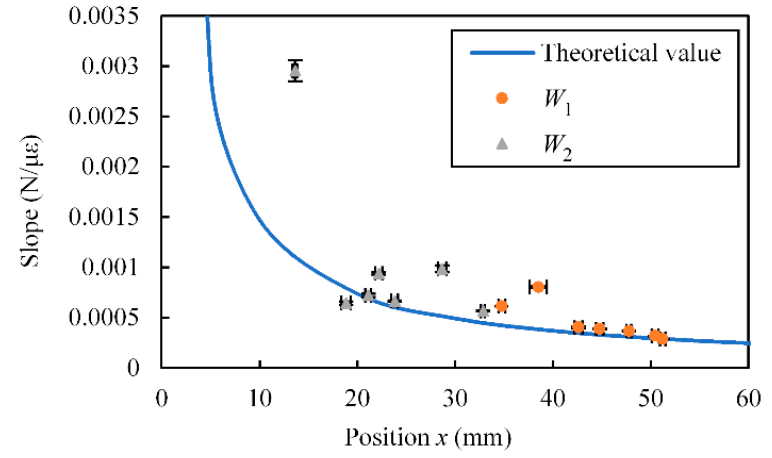
Figure 11. Relationship between x and slope for SMA FS.